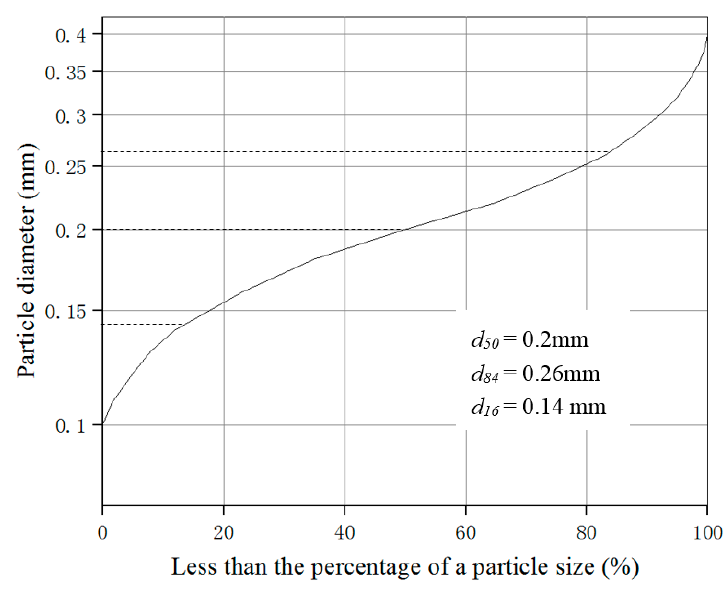
Figure 2. Cumulative frequency curve of sand particle size distribution.